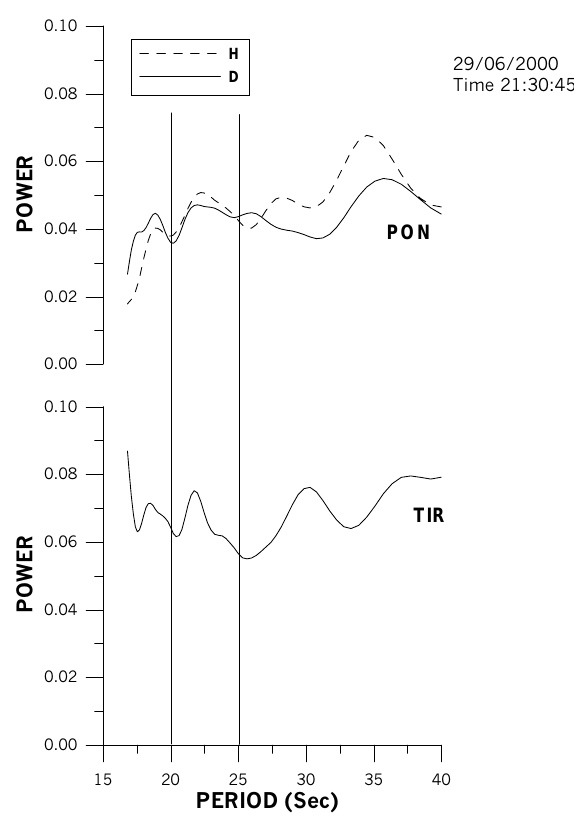
Fig. 10. The lower panel shows the power spectrum of 5 s averaged filter scintillations at Tirunalvely on the specified day and at local time. The dashed and solid curves in the upper panel, respectively, show the power spectrum of H- and D-variations of ground mag- netic data of 5 s sampling interval at Pondicherry. The range of the eigen-period has been marked by the interval between two vertical